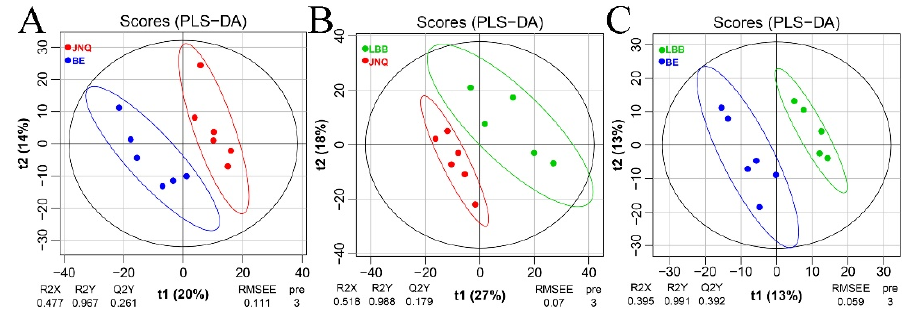
Figure 2. PLS-DA plots showing clear metabolic differences between meat samples The differences between the JNQ group (red) and BE group (blue) was ( A ), ( B ) - the JNQ group and LBB group (green), and C - the LBB group and BE group. All with 95% confidence ellipsoids.